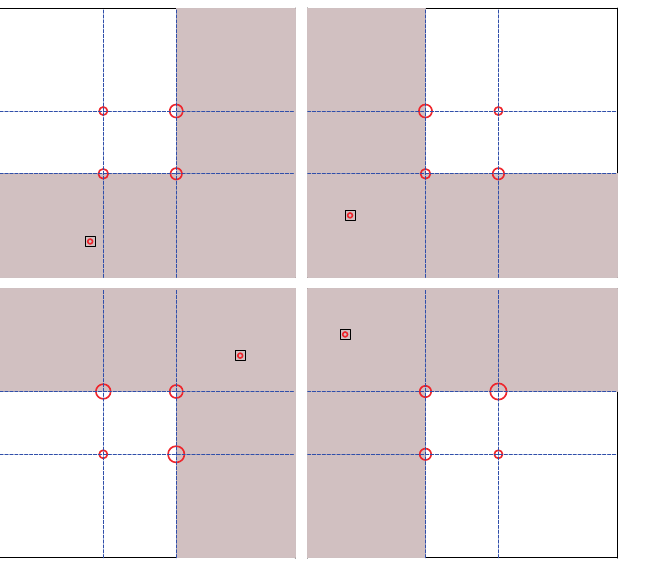
Fig. 4. Probing three-by-three internal points as a 3×3 uniform lattice. The endpoints of the initial rectangle and nodes of this lattice determine altogether 16 equal